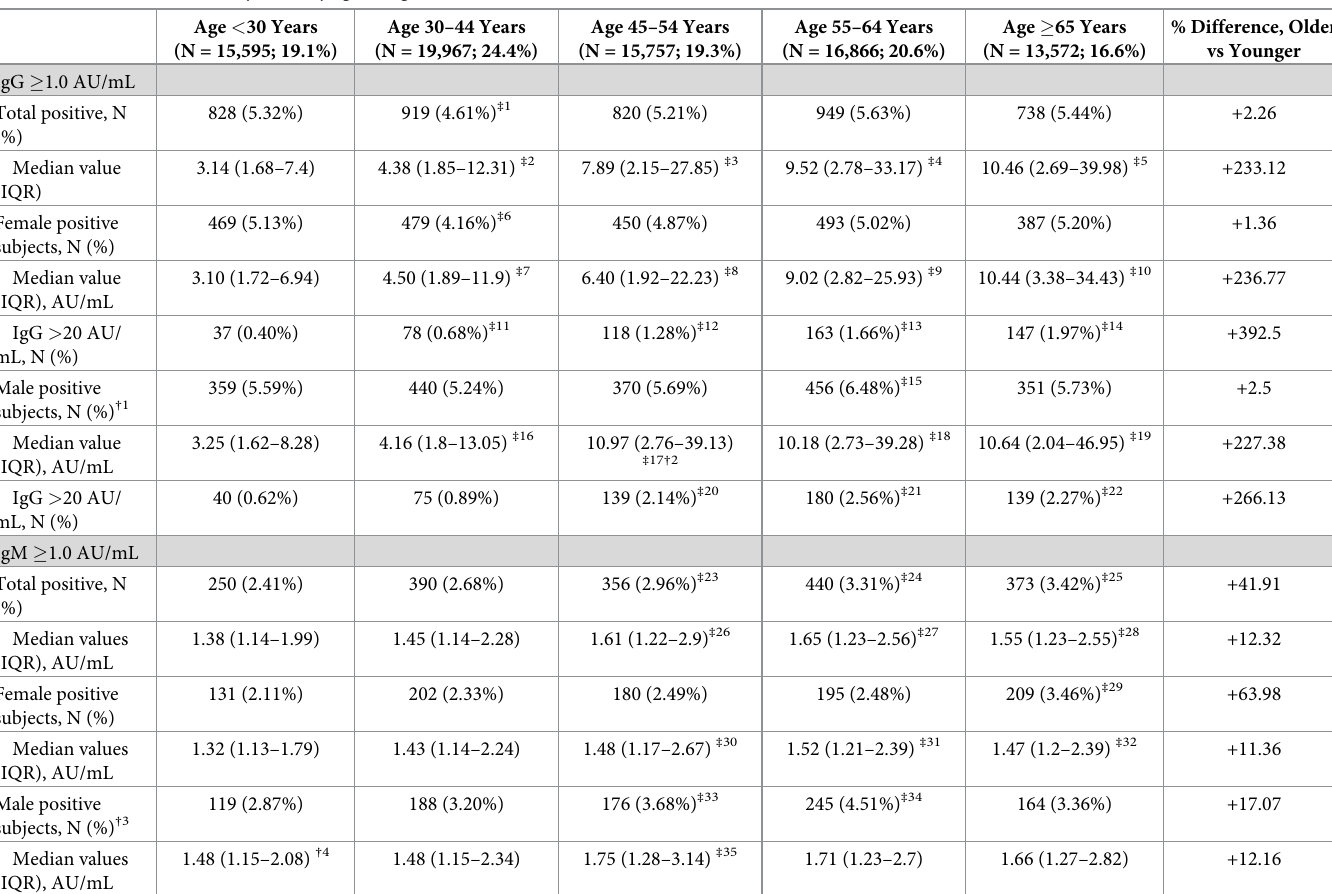
Table 5. SARS-CoV-2 antibody levels by age and gender �